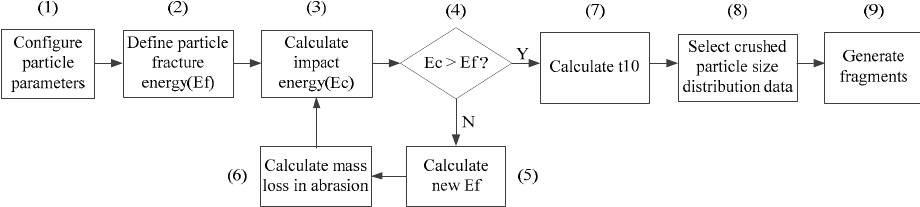
Figure 3. Calculation cycle of particle destruction and breakage caused by impact.